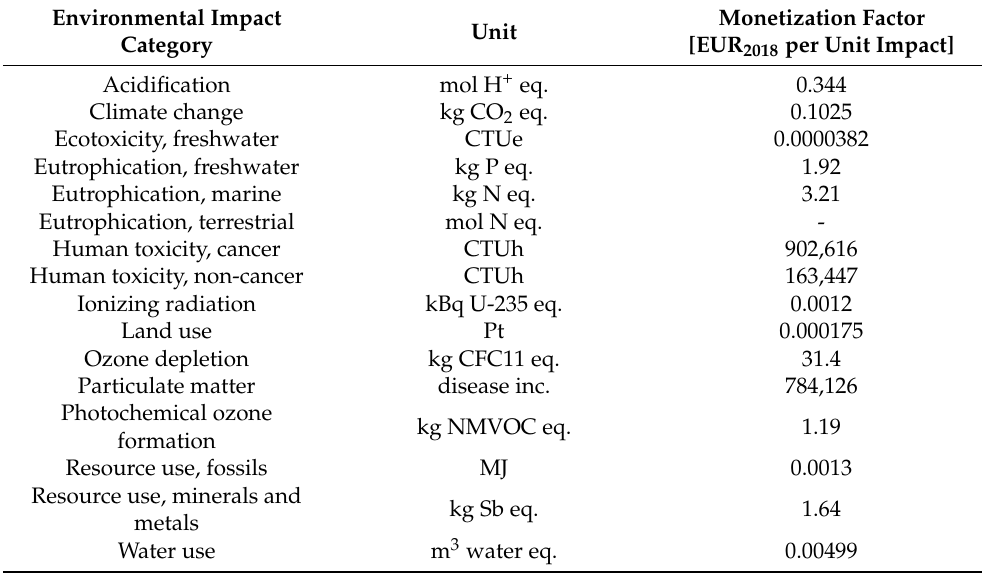
Table 3. Monetization factor for the impact categories assessed in EUR 2018 per unit impact based on Trinomics (2020)